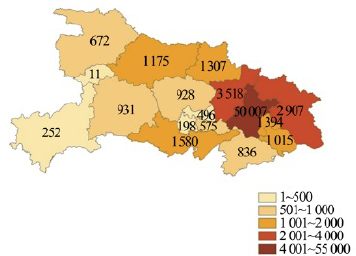
Figure 1. Spatial distribution of COVID-19.